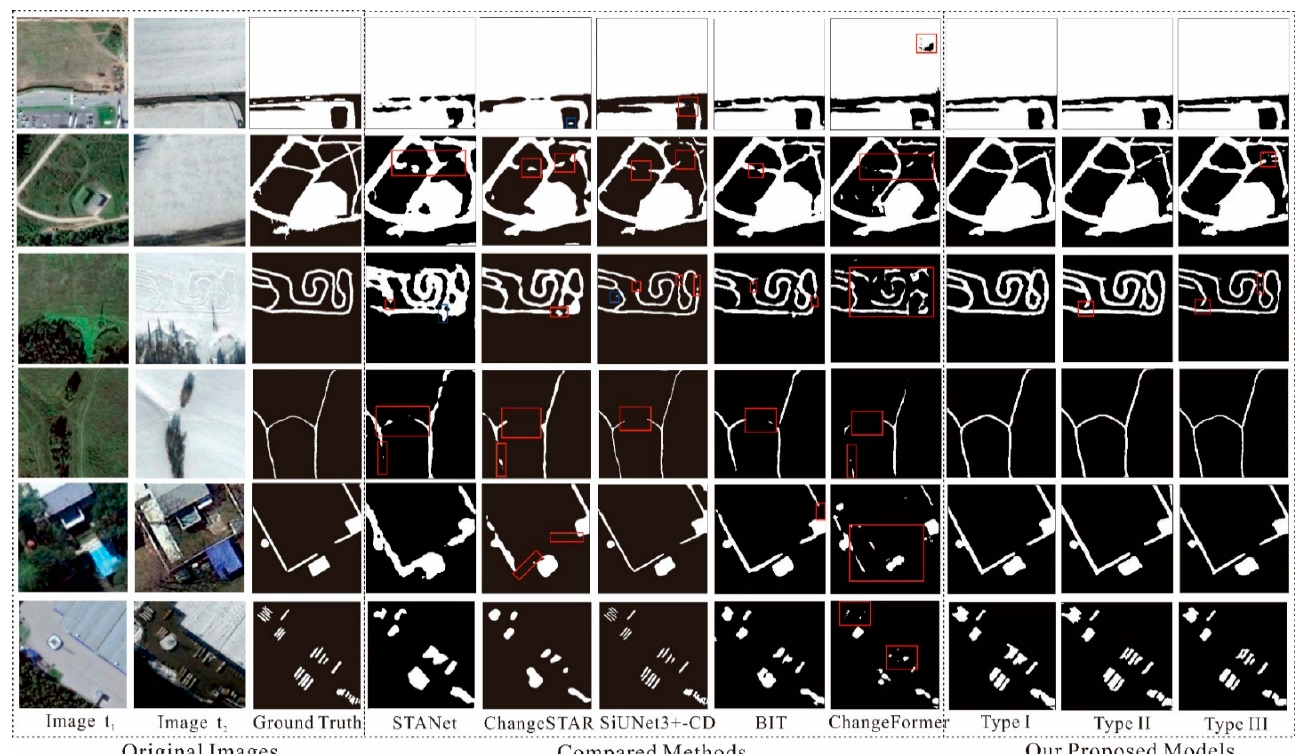
Figure 5. Visualized results of STDecoder ‐ CD series models and the compared methods on the CDD dataset. Red rectangles represent typical false negatives (the missing portions). Note: due to limited space, we could not show the prediction results of all of the algorithms listed in Table 1.